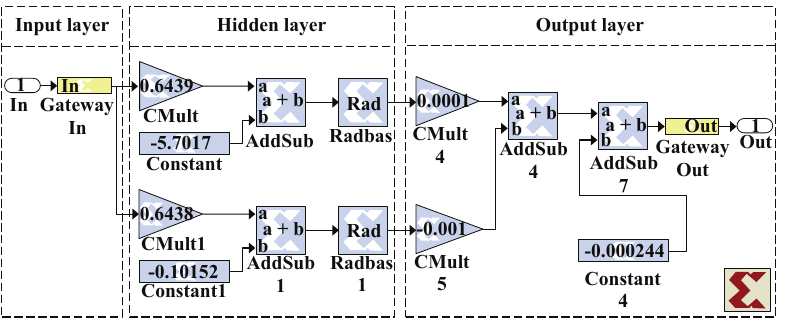
Figure 7. Implementation for NN AM/AM SSPA pre-distorter. Figure 8 represents the Register Transfer Level (RTL) schematic of Figures 6 and 7, while Figures 9 and 10 represent a zoom on both entities AM/AM and AM/PM of Figure